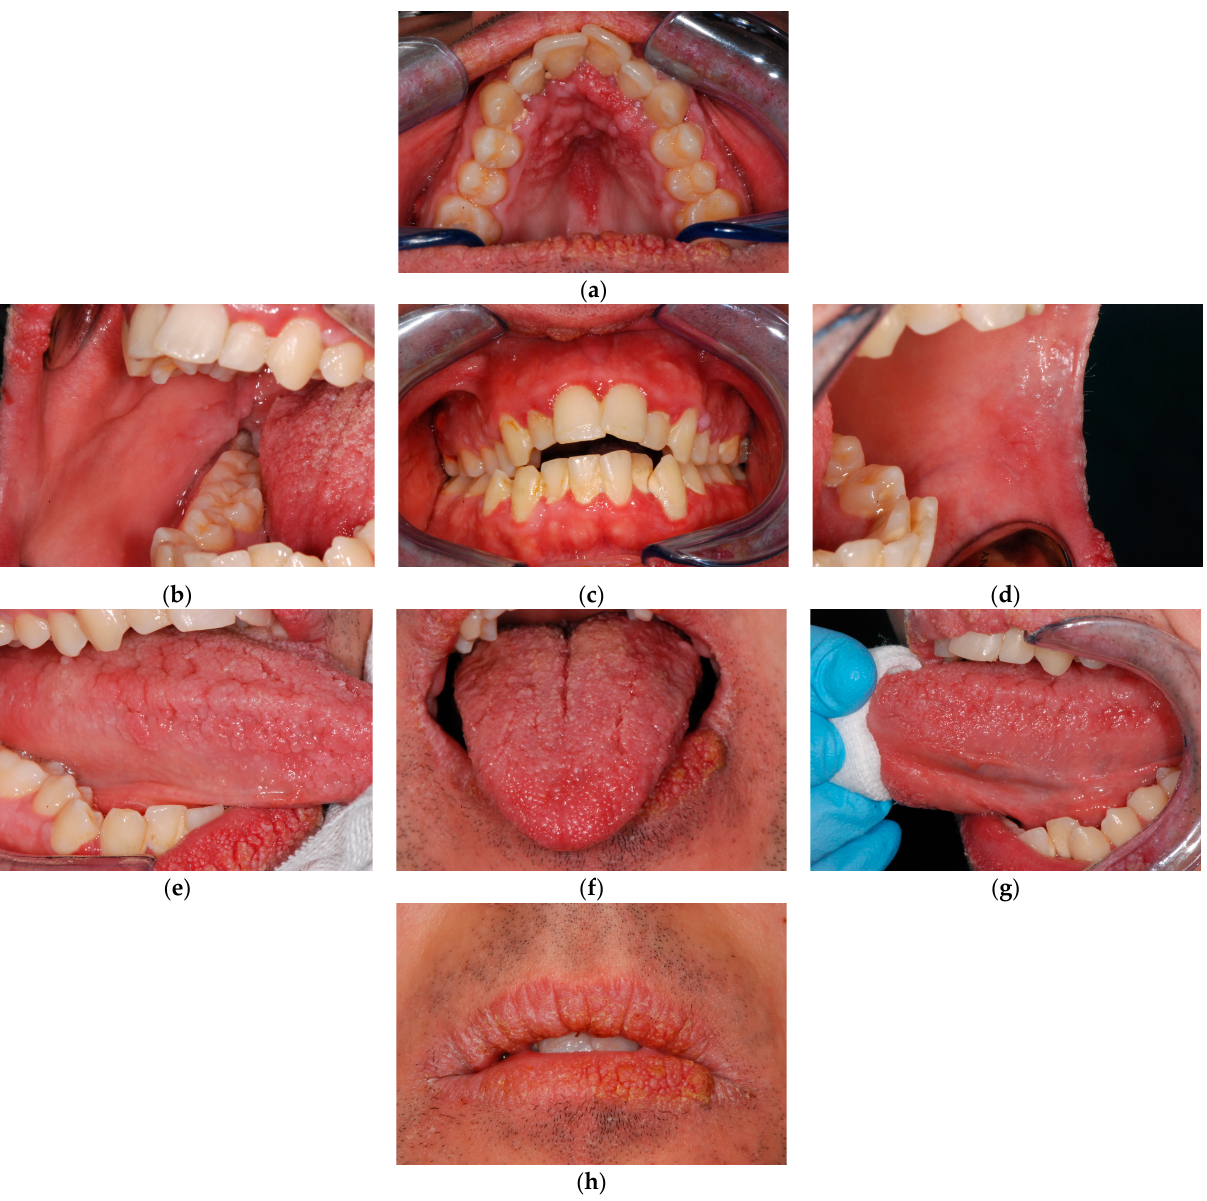
Figure 1. Patient 1, clinical lesions. ( a ) Palate. ( b ) Right buccal mucosa. ( c ) Gingiva. ( d ) Left buccal mucosa. ( e ) Right lateral lingual border. ( f ) Tongue. ( g ) Left lateral lingual border. ( h ) Labial vermilion and perioral skin.